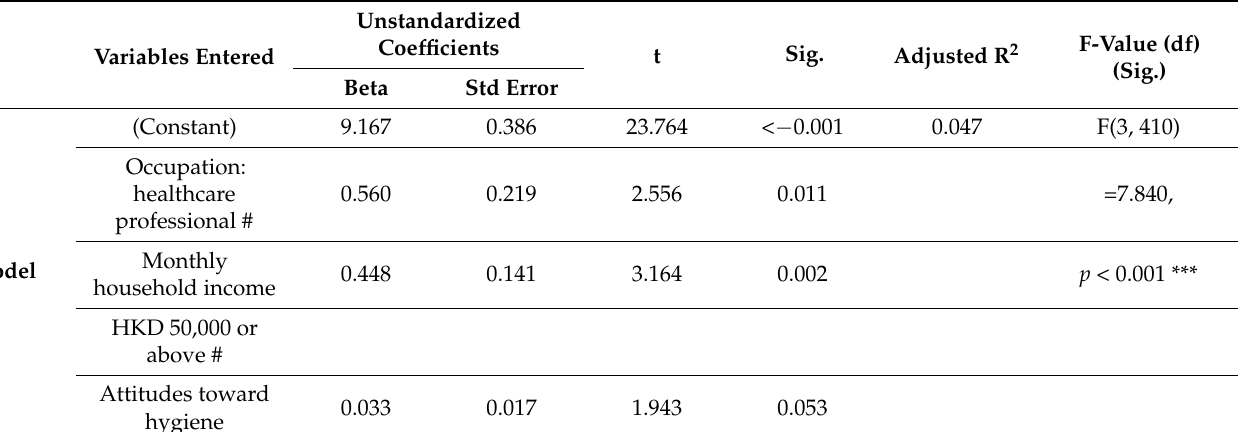
Table 6. The final model of regression analyses.